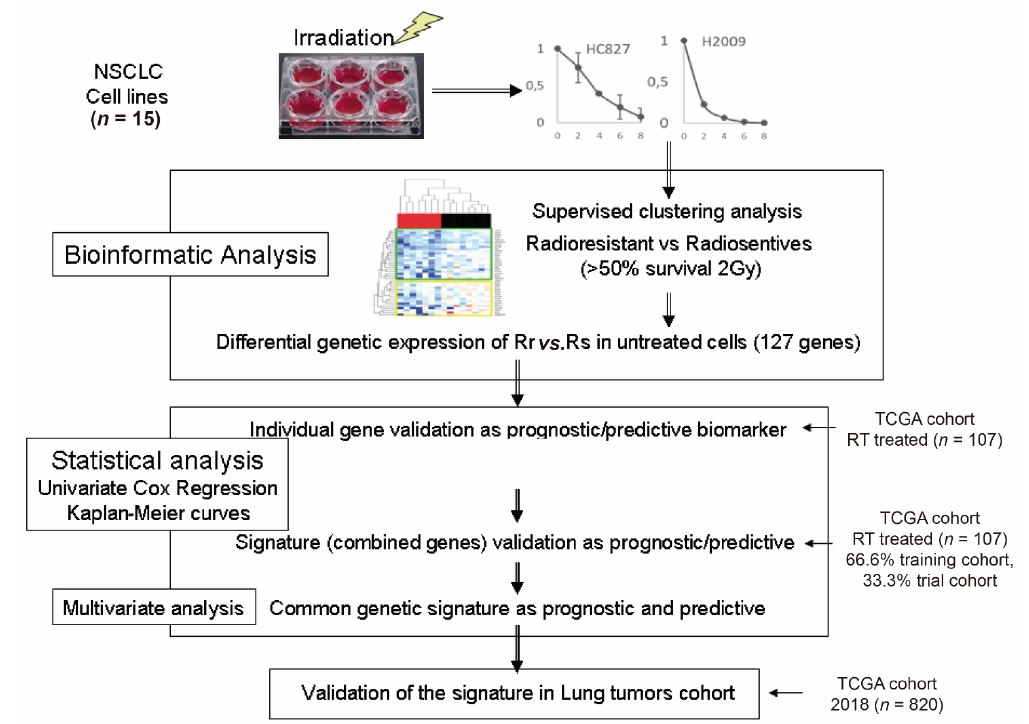
Figure 1. Diagram of the steps followed in the present work.